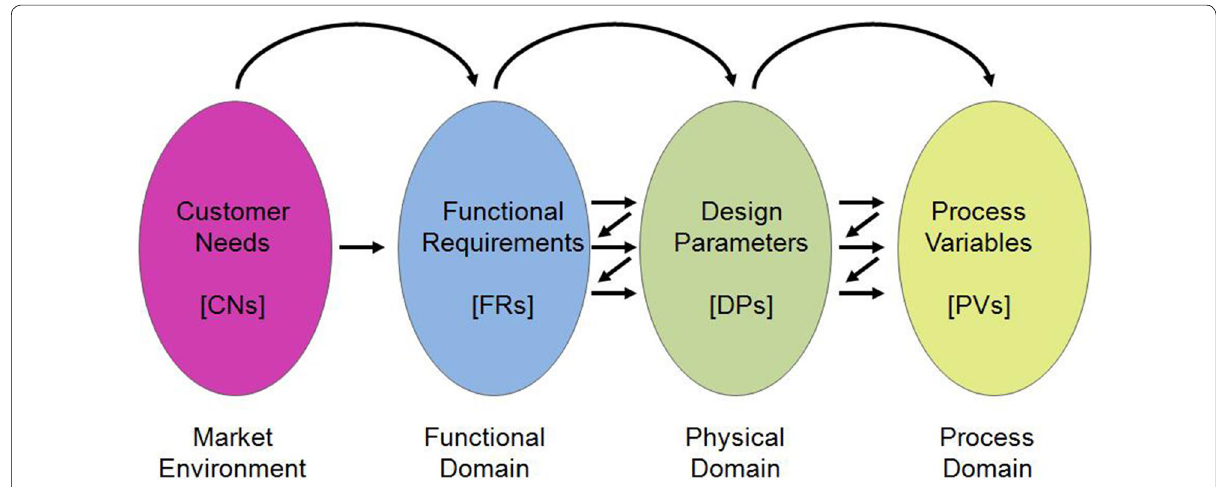
Figure 1 Mapping processes of domain sand areas (Suh,